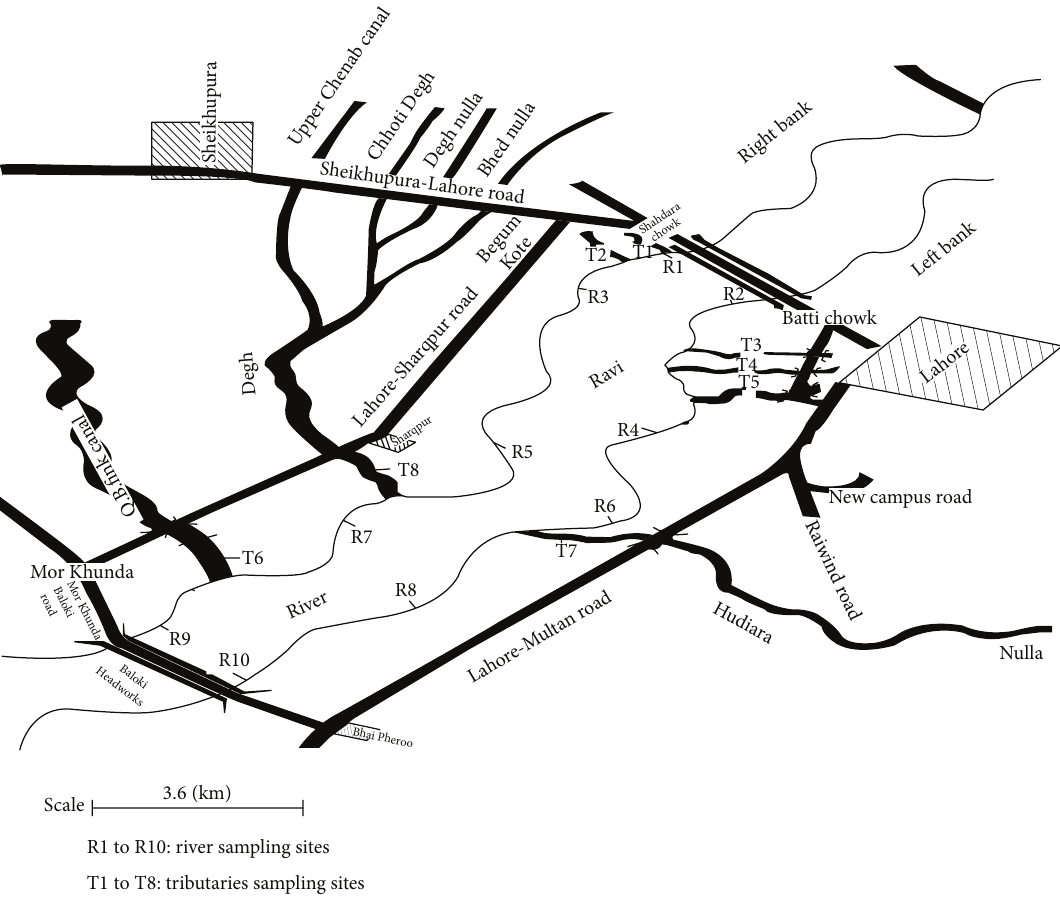
Figure 1: Map of area under study showing sampling